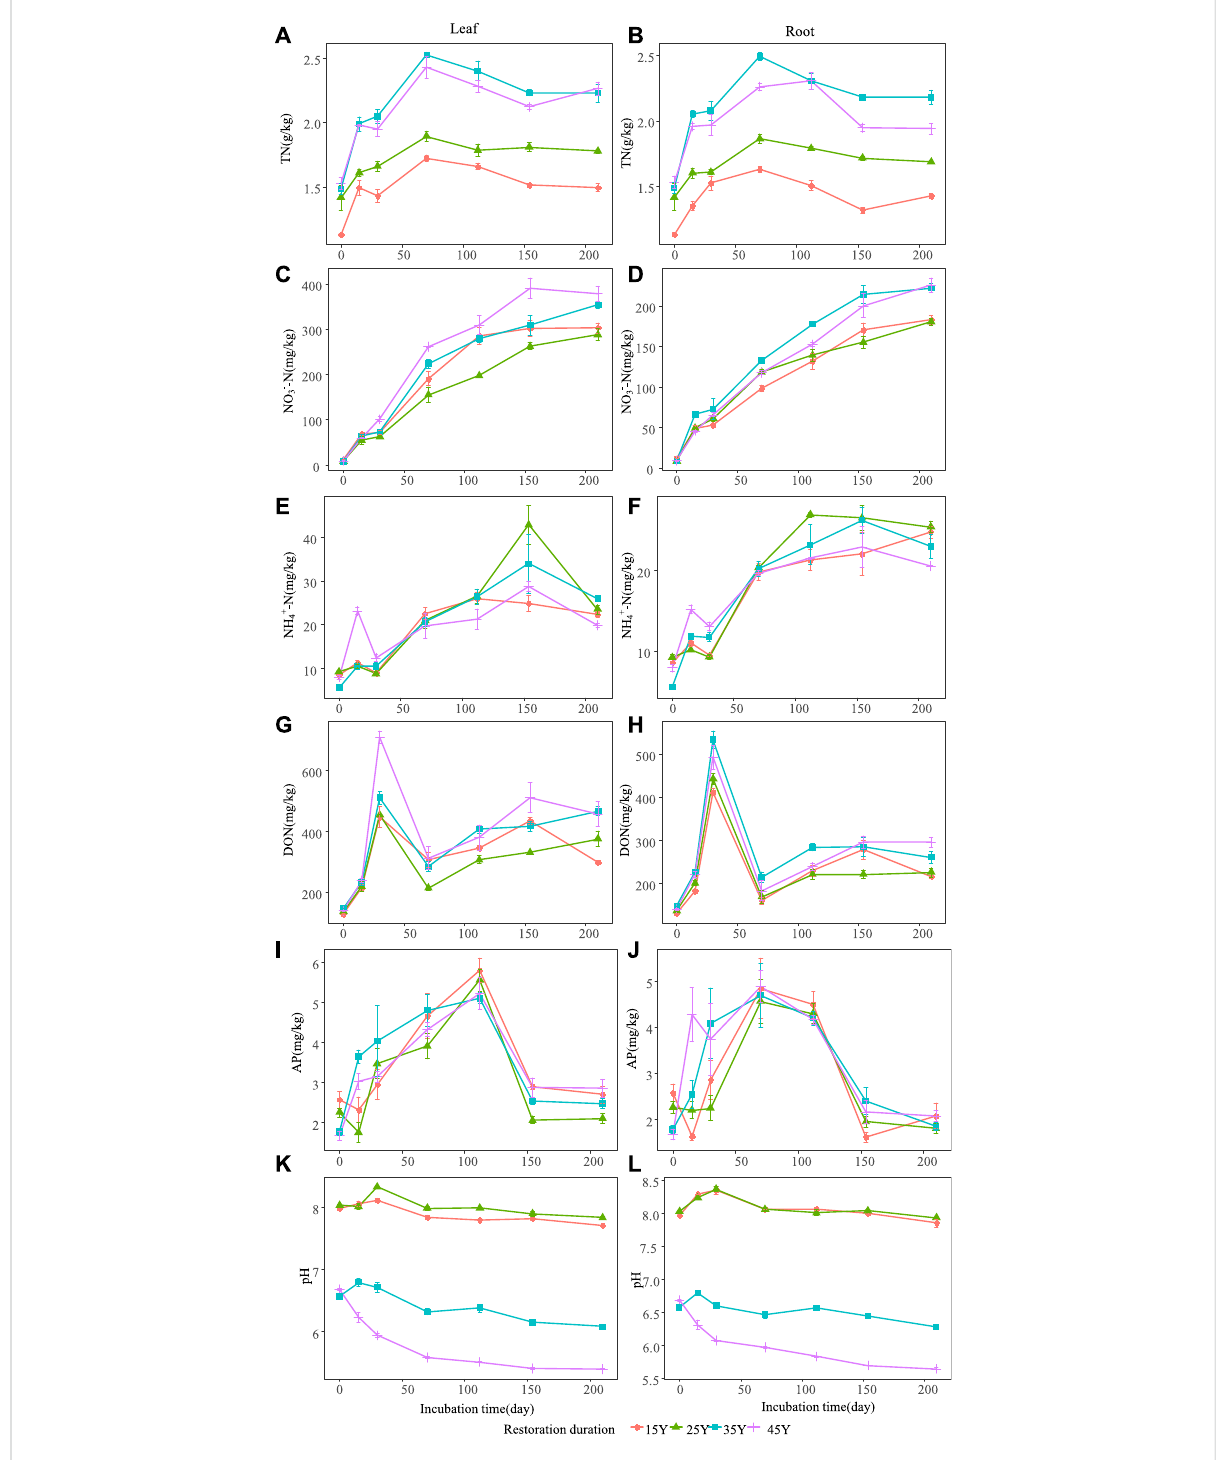
FIGURE 4 Temporaldynamicsofsoilpropertiesaftertheleafandrootlitteradditionoffourdifferentrestorationdurationsof Robiniapseudoacacia stands. Values are means ± standard error. The dynamic changes of soil total nitrogen when leaf litter and root addition (A – B) ; the dynamic changes of soil nitrate nitrogen when leaf litter and root addition (C – D) ; the dynamic changes of soil ammonia nitrogen when leaf litter and root addition (E – F) ; the dynamic changes of soil dissolved organic nitrogen when leaf litter and root addition (G – H) ; the dynamic changes of soil available phosphorus when leaf litter and root addition (I – J) ; the dynamic changes of soil pH when leaf litter and root addition (K – L)